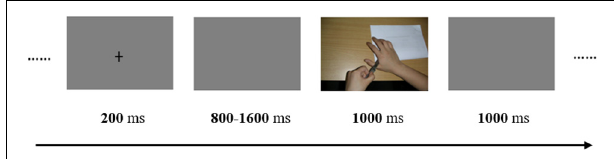
FIGURE 1 | Illustration of the temporal sequence of an individual